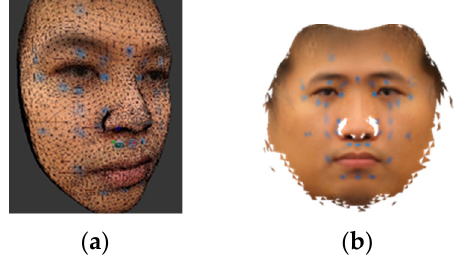
Figure 3. 3D acupoint annotation. ( a ) acupoint annotation, ( b ) isomap texture.